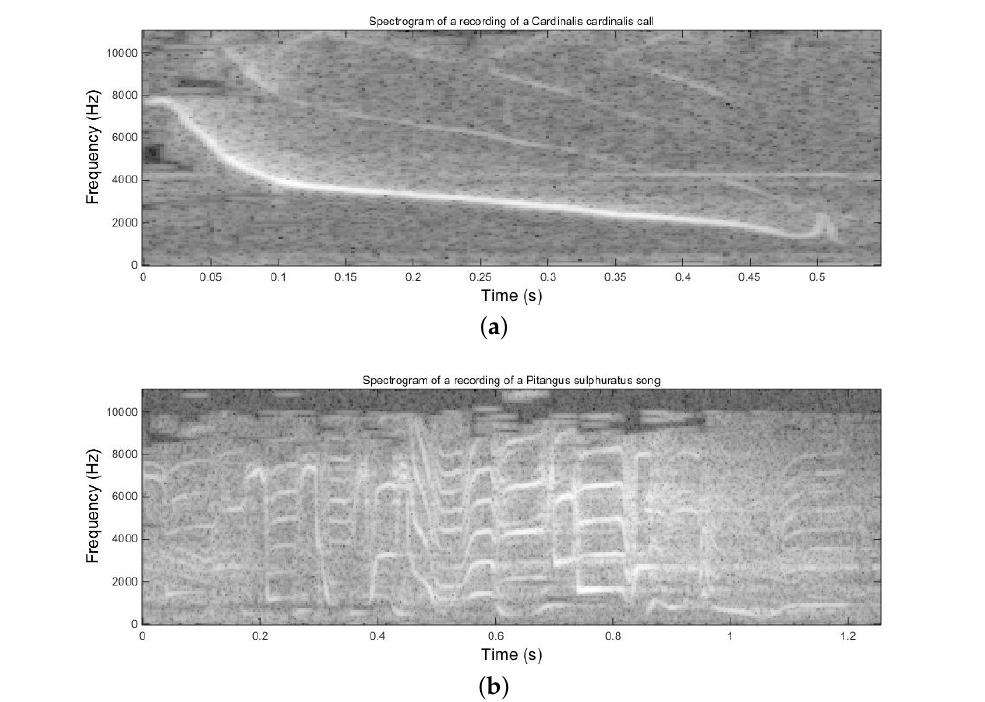
Figure 14. Examples of the complexity in the vocalizations: ( a ) noncomplex vocalization; and ( b ) complex